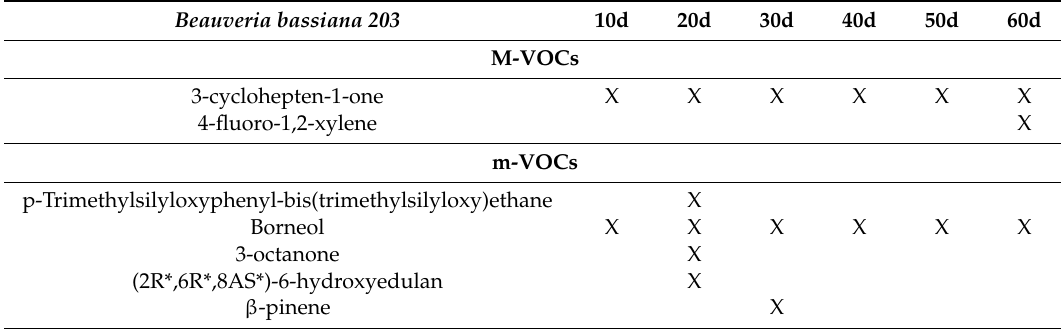
Table 2. M-VOCs and m-VOCs produced by B. bassiana 203 during 60 days of growth. Abbreviations: VOC = volatile organic compound, M-VOCs = major VOCs, m-VOCs = minor VOCs, d = days after inoculation.